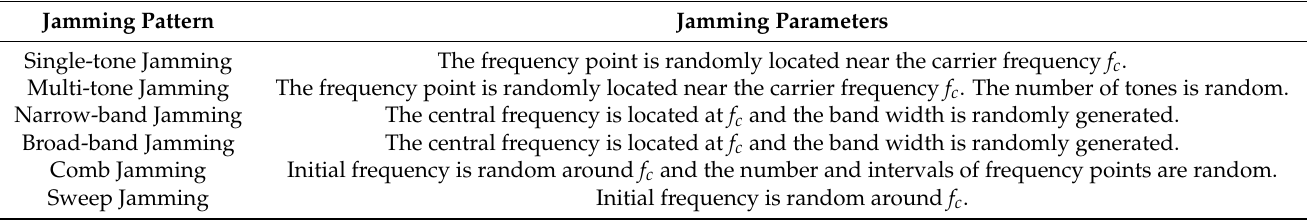
Table 5. Simulation parameters of jamming signal. Jamming Pattern Jamming Parameters Single-tone Jamming The frequency point is randomly located near the carrier frequency f c . Multi-tone Jamming The frequency point is randomly located near the carrier frequency f c . The number of tones is random. Narrow-band Jamming The central frequency is located at f c and the band width is randomly generated. Broad-band Jamming The central frequency is located at f c and the band width is randomly generated. Comb Jamming Initial frequency is random around f c and the number and intervals of frequency points are random. Sweep Jamming Initial frequency is random around f c